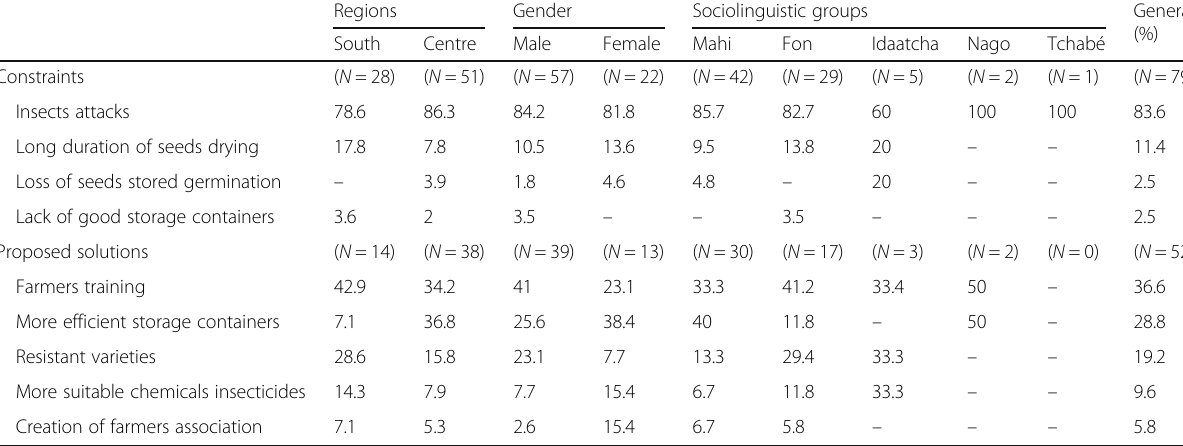
Table 2 Kersting ’ s groundnut grains storage constraints and proposed solutions to overcome them throughout the study area in function of regions, gender and sociolinguistic groups Regions Gender Sociolinguistic groups